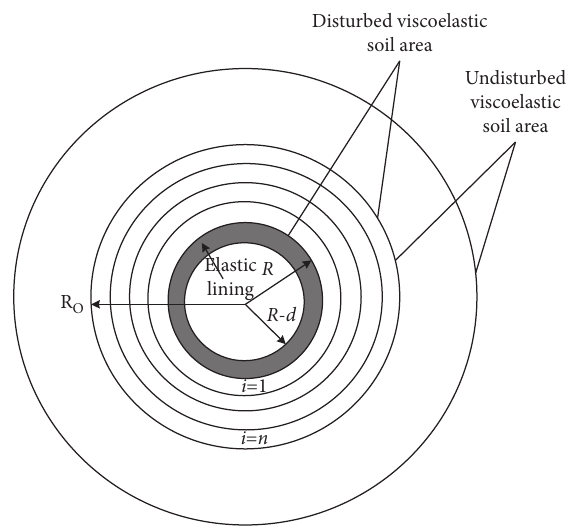
Figure 1: Model of viscoelastic radially inhomogeneous soil-cir- cular tunnel lining.